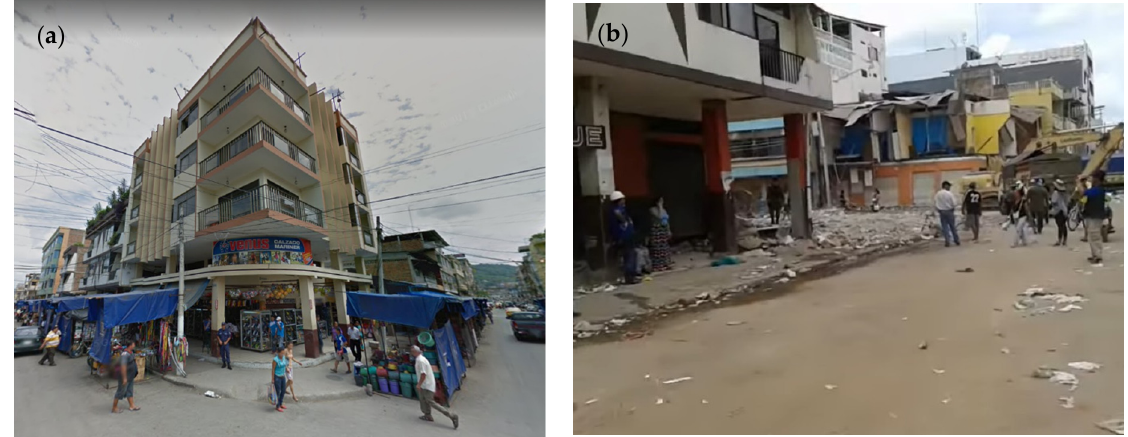
Figure 2. Marinero building located on Chile Street in Portoviejo, ( a ) before the earthquake and ( b ) after the earthquake.